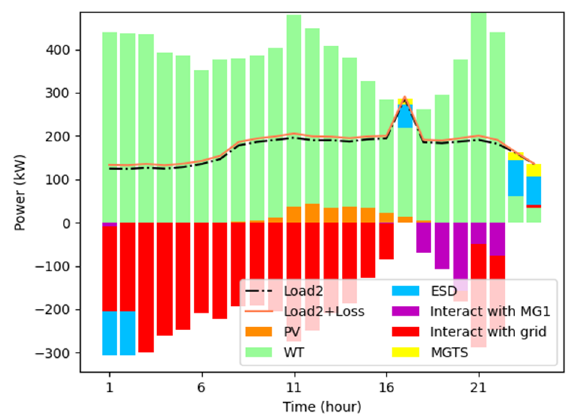
Figure 11. Electrical balance of MG 2.